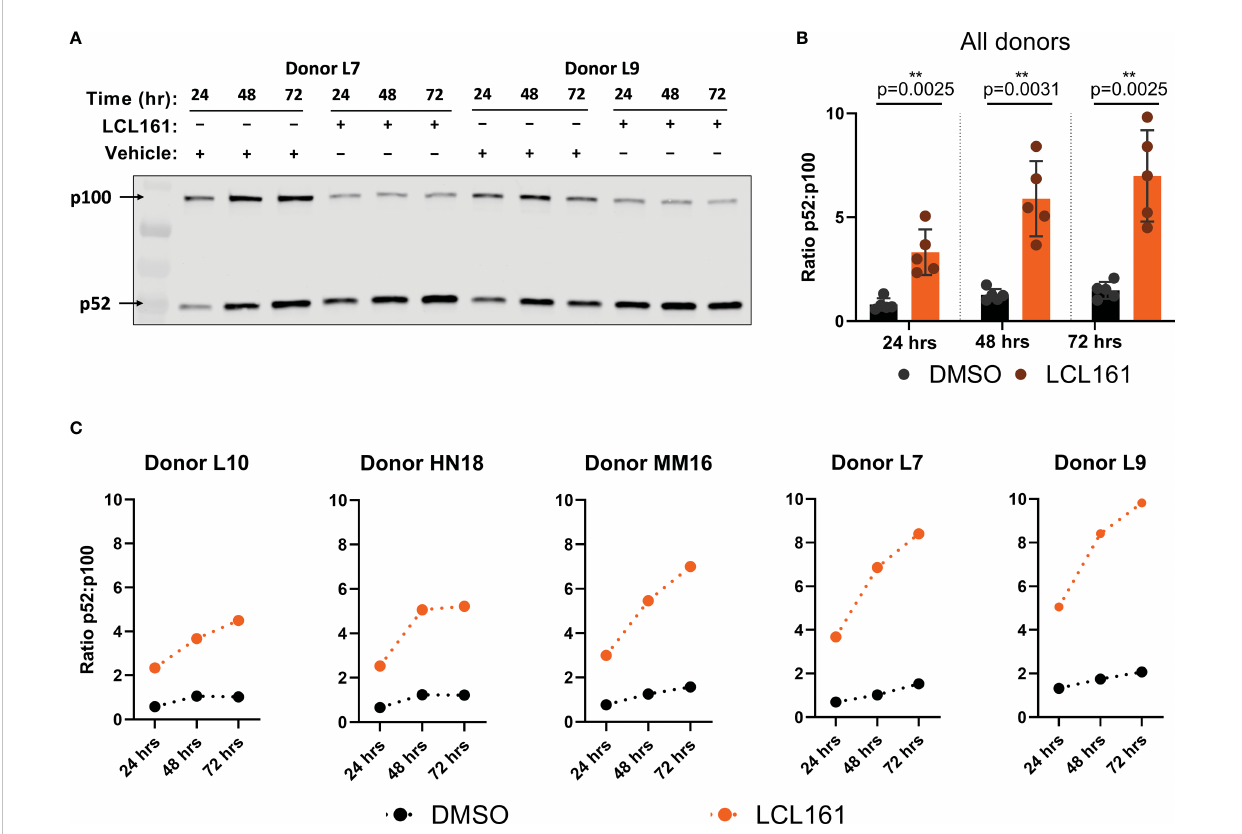
FIGURE 1 LCL161 activates the ncNF- k B signaling pathway in TAC T cells. 0.5x10 6 TAC T cells were stimulated on plates coated with 0.05 ng/mL BCMA-Fc and either DMSO or 0.625 µM LCL161. Cells were collected and lysates were processed, ran on 4-20% polyacrylamide gels, and immunoblotted for NF- k B2 p100/p52. (A) Representative western blot indicating levels of NF- k B2 p100 and p52. (B-C) Signal quanti fi cation and normalization using Li-Cor Empiria software. NF- k B2 p100 and p52 signal was quanti fi ed and normalized to total protein loaded per lane and a ratio was calculated. (B) n=5. **p<0.01 as calculated by two- tailed paired t test. (C) data from individual donors in (B) These data represent 2 independent